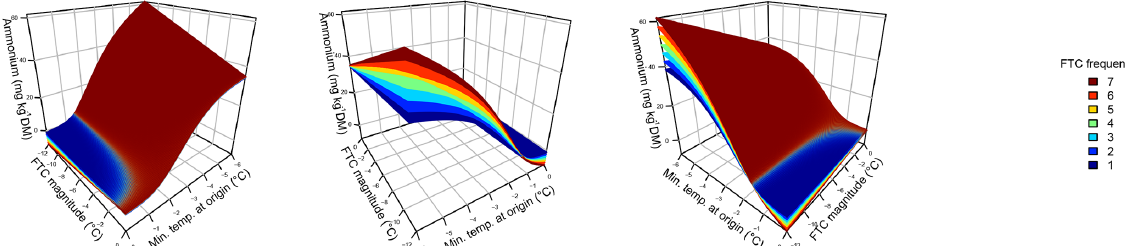
Figure 2. Ammonium concentrations were best explained by the three-fold interactive effects of winter climatic origin (expressed as long- term mean minimum winter temperature at the origin), FTC magnitude (expressed as the minimum temperature experienced during the FTC manipulation and displayed for freezing temperatures), and FTC frequency during the FTC manipulation. FTC: freeze–thaw cycle. The four-dimensional representation is displayed from three different angles (see Supplement C for an animated version) and is based on the best model fit in the hierarchical regression analysis (model 15 in Table 4 with coefficients a 1 = 35 . 77052; a 2 = 9 . 00972; a 3 = 0 . 94421; a 4 = 0 . 06278; a 5 = 0 . 10997; a 6 = 0 .